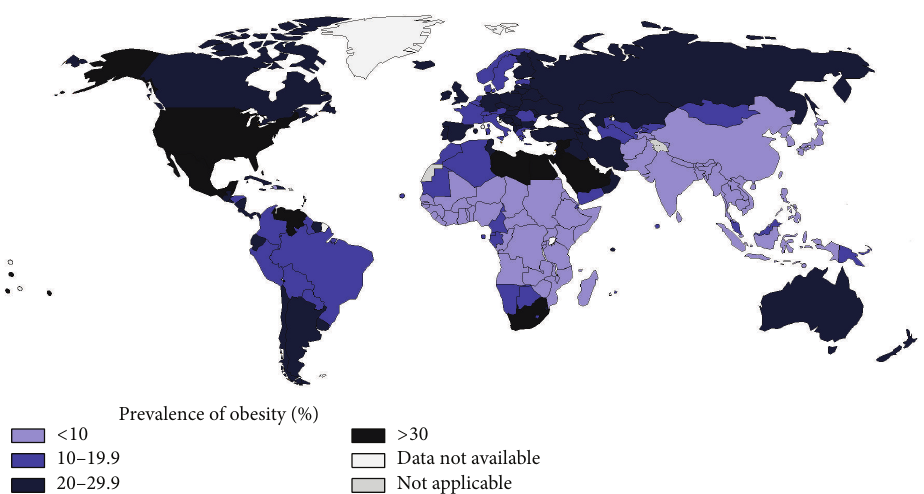
Figure 1: Worldwide Overall percentage of obesity prevalence (2008). Data source: WHO [1].